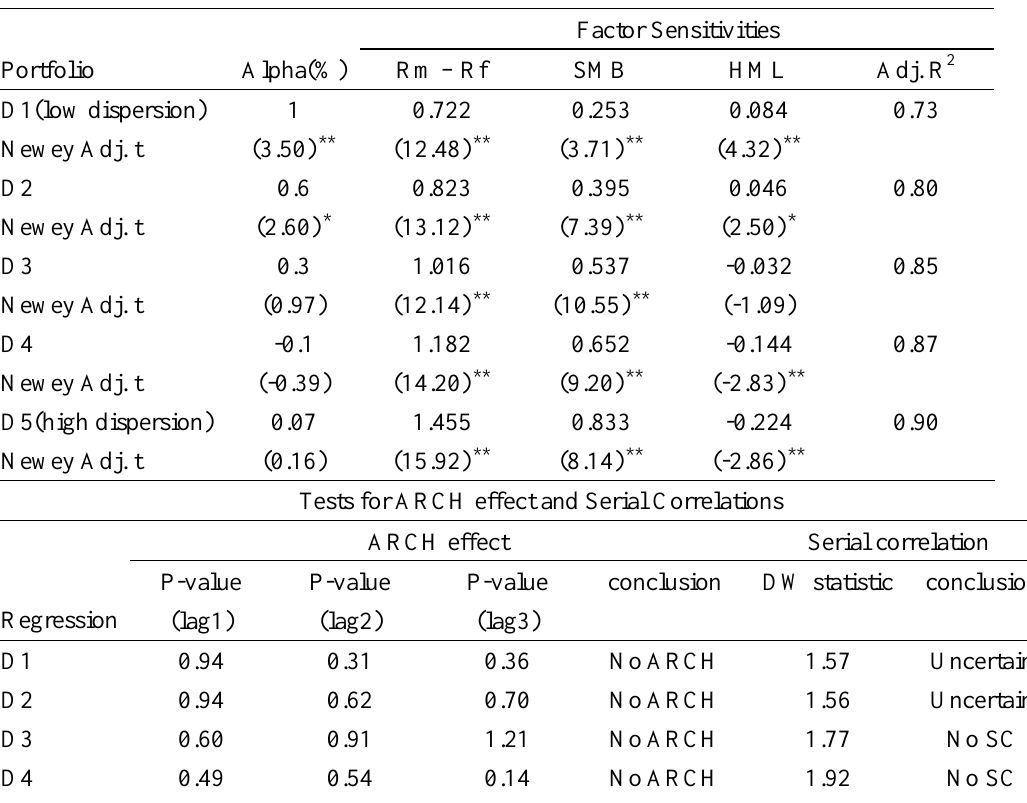
Table 3: Results of Fama-French Three-Factor Models (1999.1 -